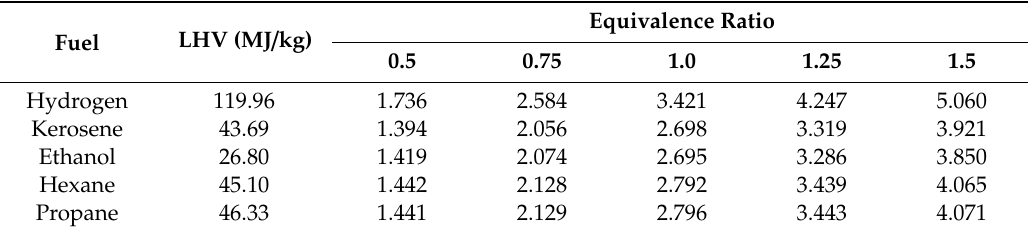
Table 5. Calculated chemical energy content in 1 kg of fuel–air mixture for di ff erent equivalence ratios based on LHV.